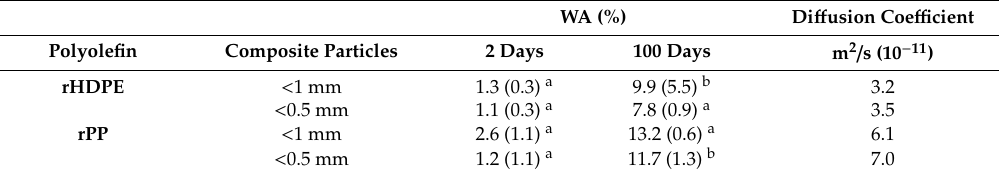
Table 5. Water soak properties of polyolefin